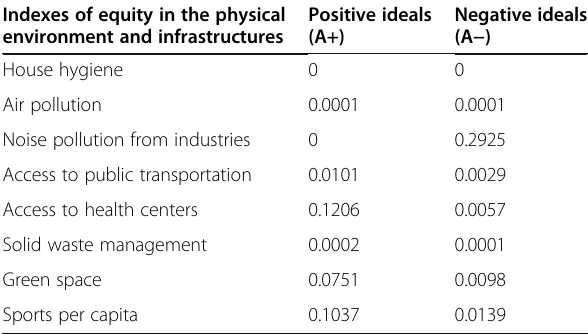
Table 5 Positive and negative ideals